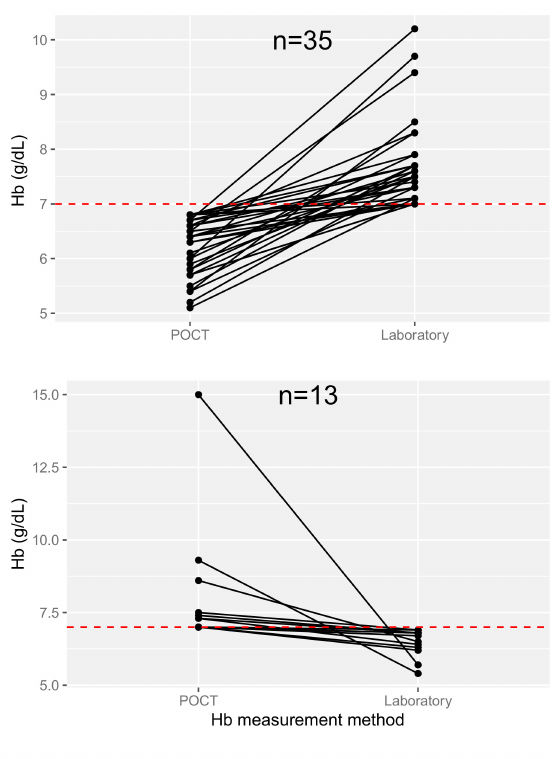
Figure 3. Discordances between pretransfusion Hb level ( ≥ or <7 g/dL) depending on the measure- ment method (point-of-care testing vs. laboratory complete blood